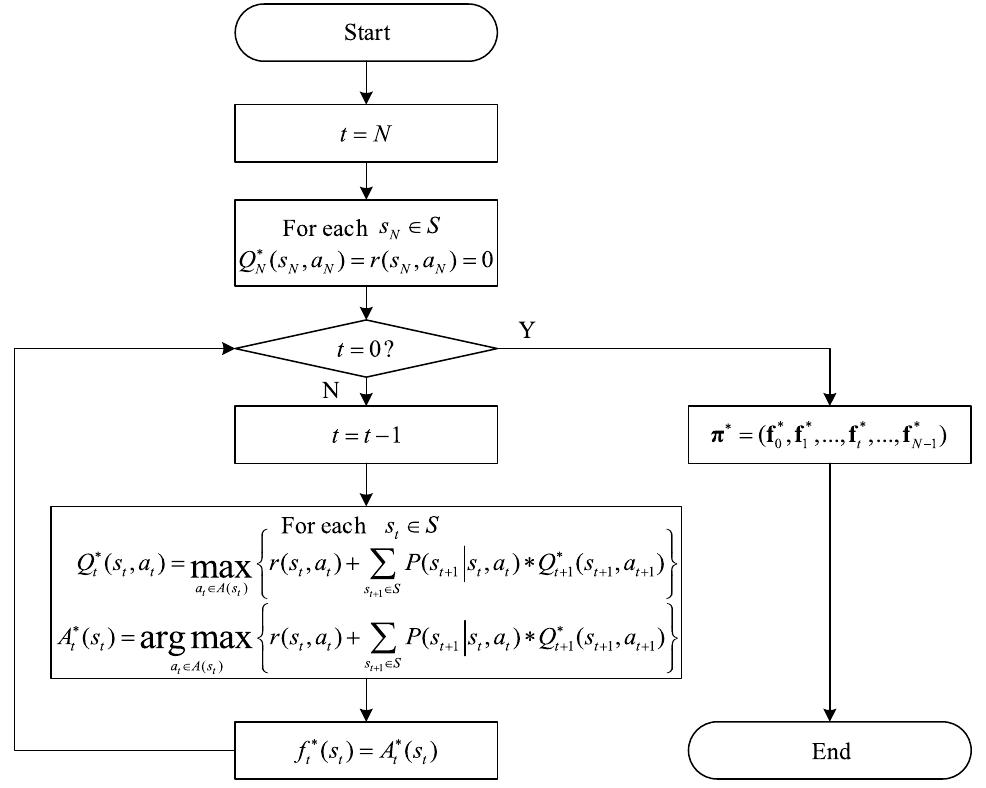
Figure 3. The flow chart of the backwards induction